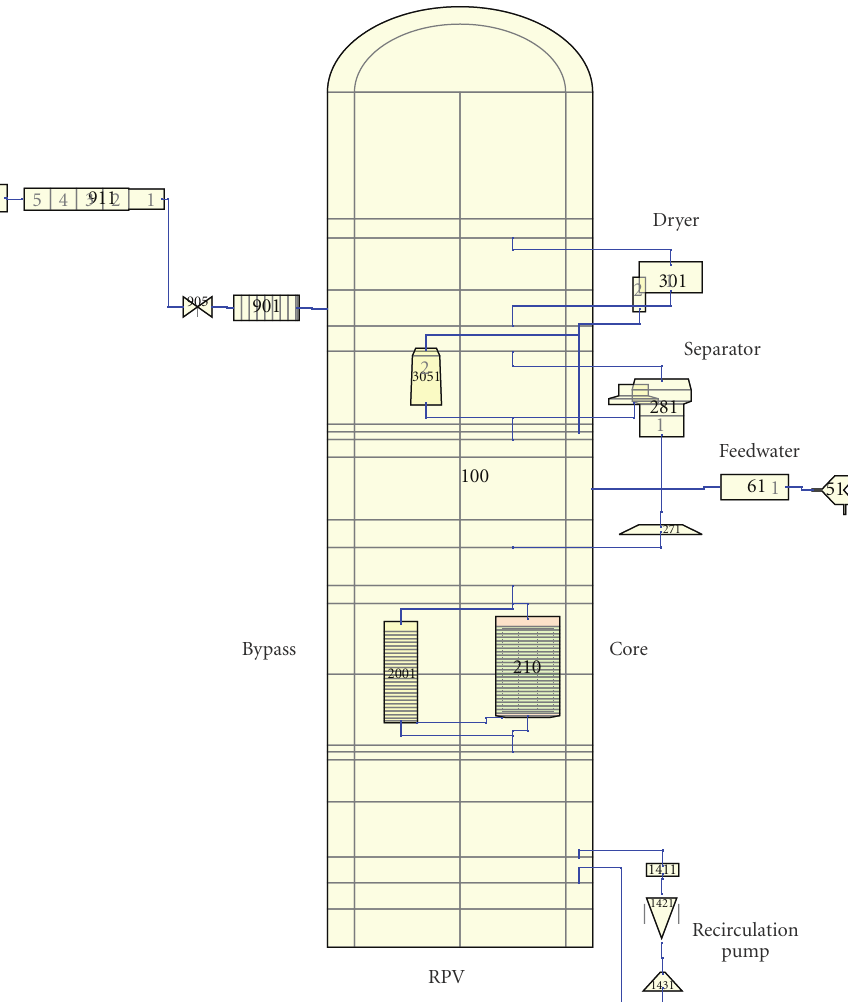
Figure 12: Integral BWR plant model of the BWR as represented by SNAP (2D model).